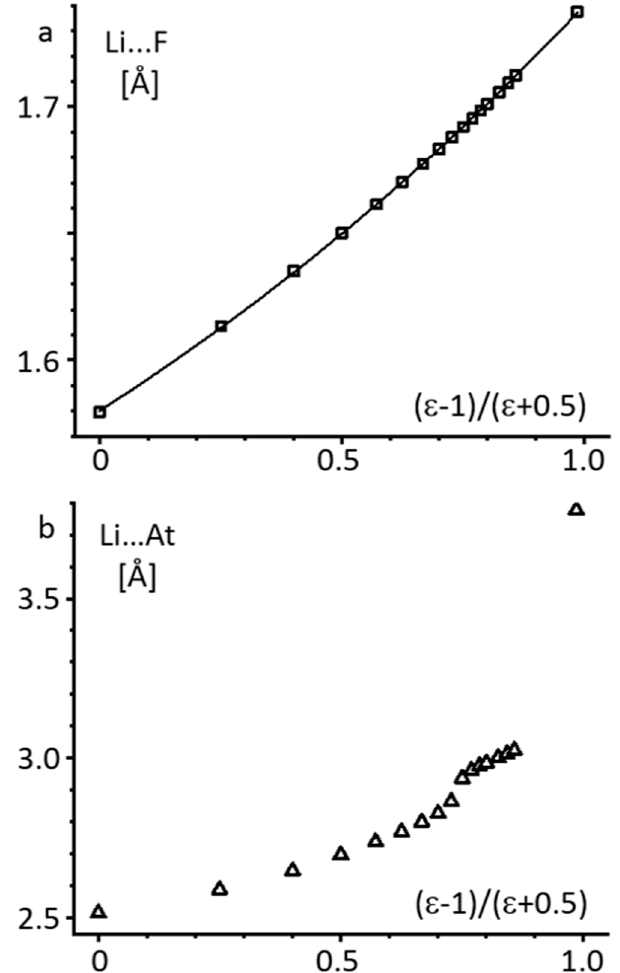
Figure 3. The alkali metal ··· halogen distance in LiF ( a ) and LiAt ( b ) as a function of ( ε − 1)/( ε + 0.5) under the PCM approximation at 1 ≤ ε = ≤ 100.